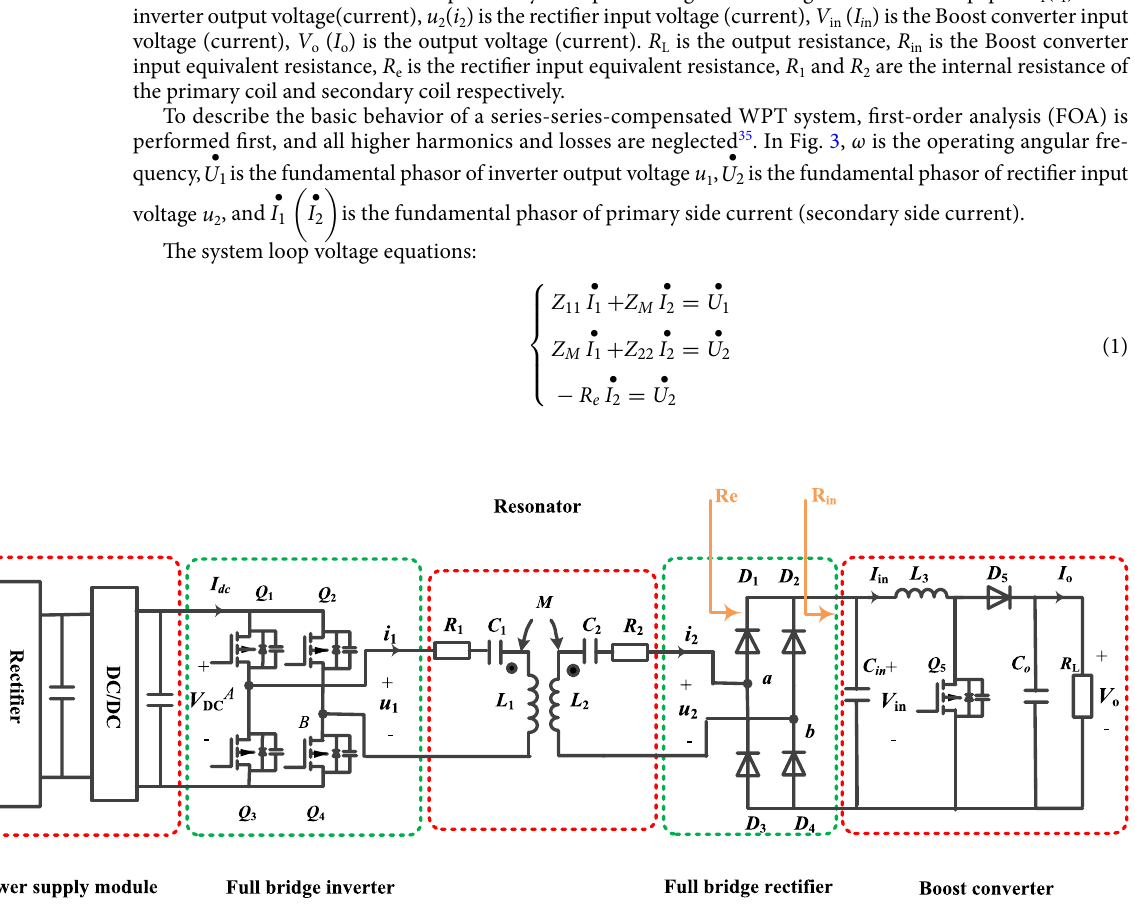
Figure 1. SS-type MCR-WPT system structure with cascaded Boost